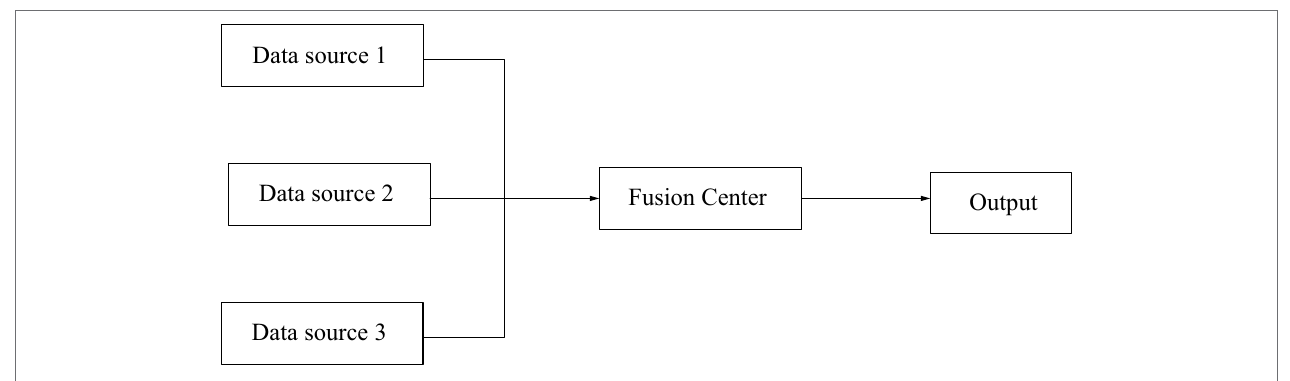
FIGURE 3 | Centralized structure of information convergence.